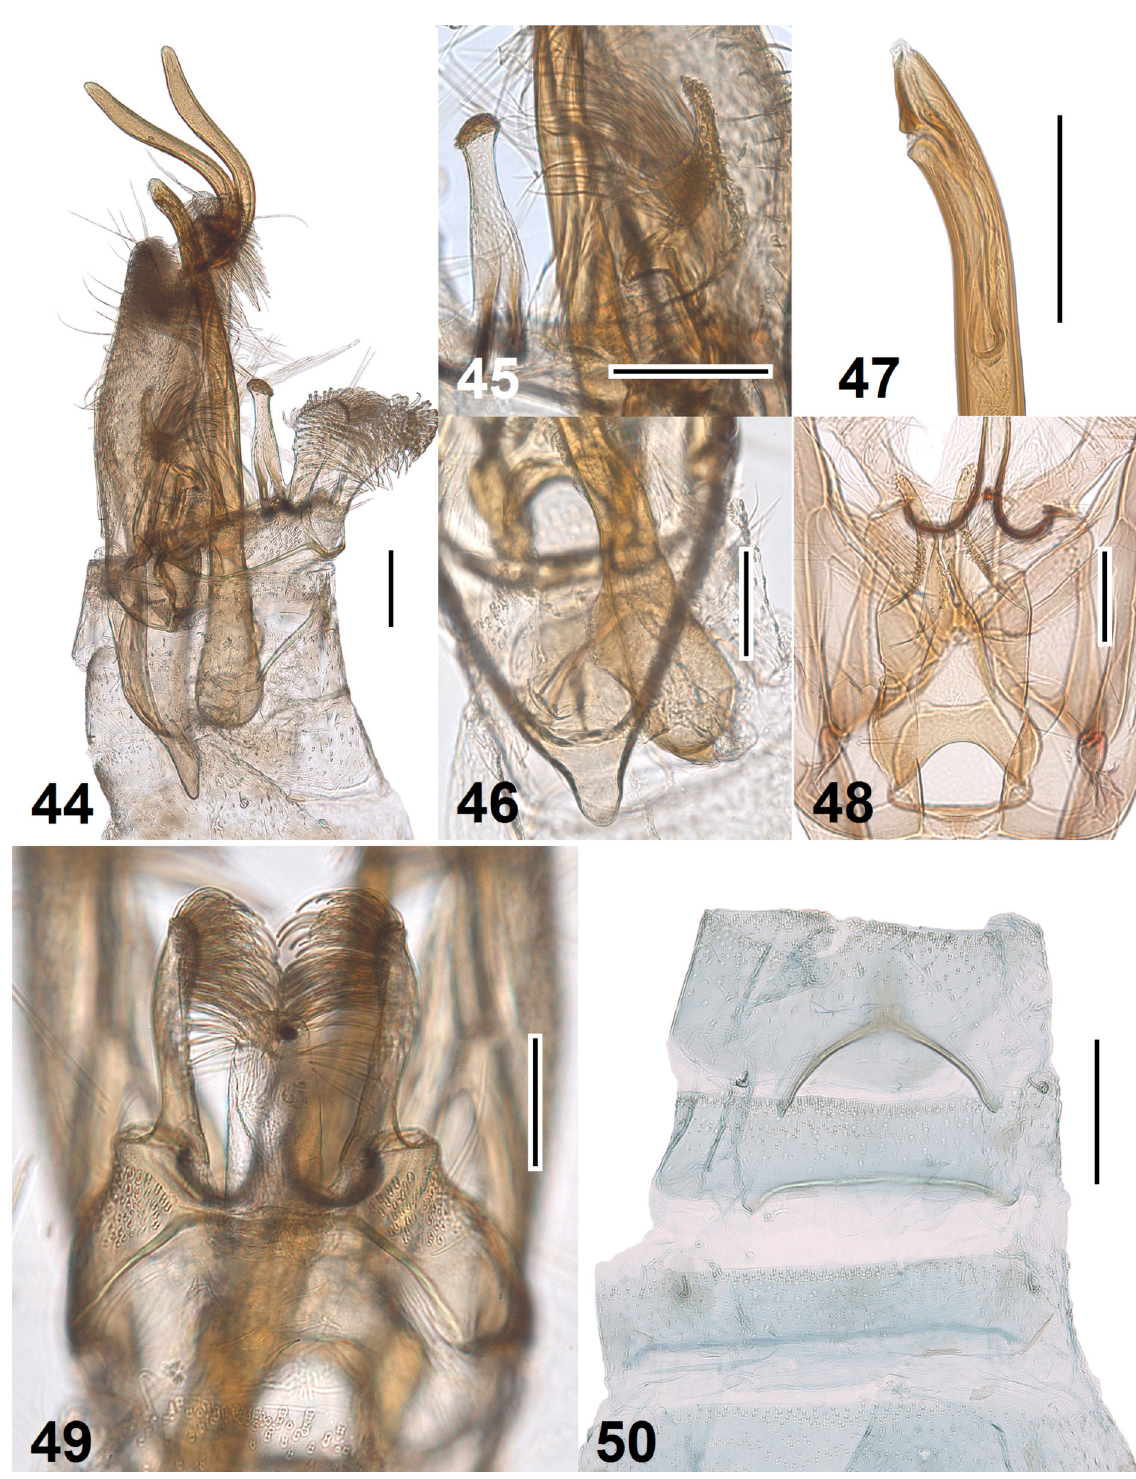
Figs 44–50. Elachista capricornis Sruoga & Kaila sp. nov., male genitalia. 44–46, 48–49 . Paratype, ♂ (MZH VS2/22.11.18, in glycerol before permanent mounting in Euparal). 44 . Lateral view. 45 . Juxta and gnathos, lateral view. 46 . Proximal part of phallus. 47, 50 . Holotype, ♂ (MZH VS2/21.11.18, in glycerol before permanent mounting in Euparal). 47 . Distal part of phallus. 48 . Juxta region. 49 . Uncus lobes, dorsal view. 50 . Distal part of abdomen. Scale bars = 0.1